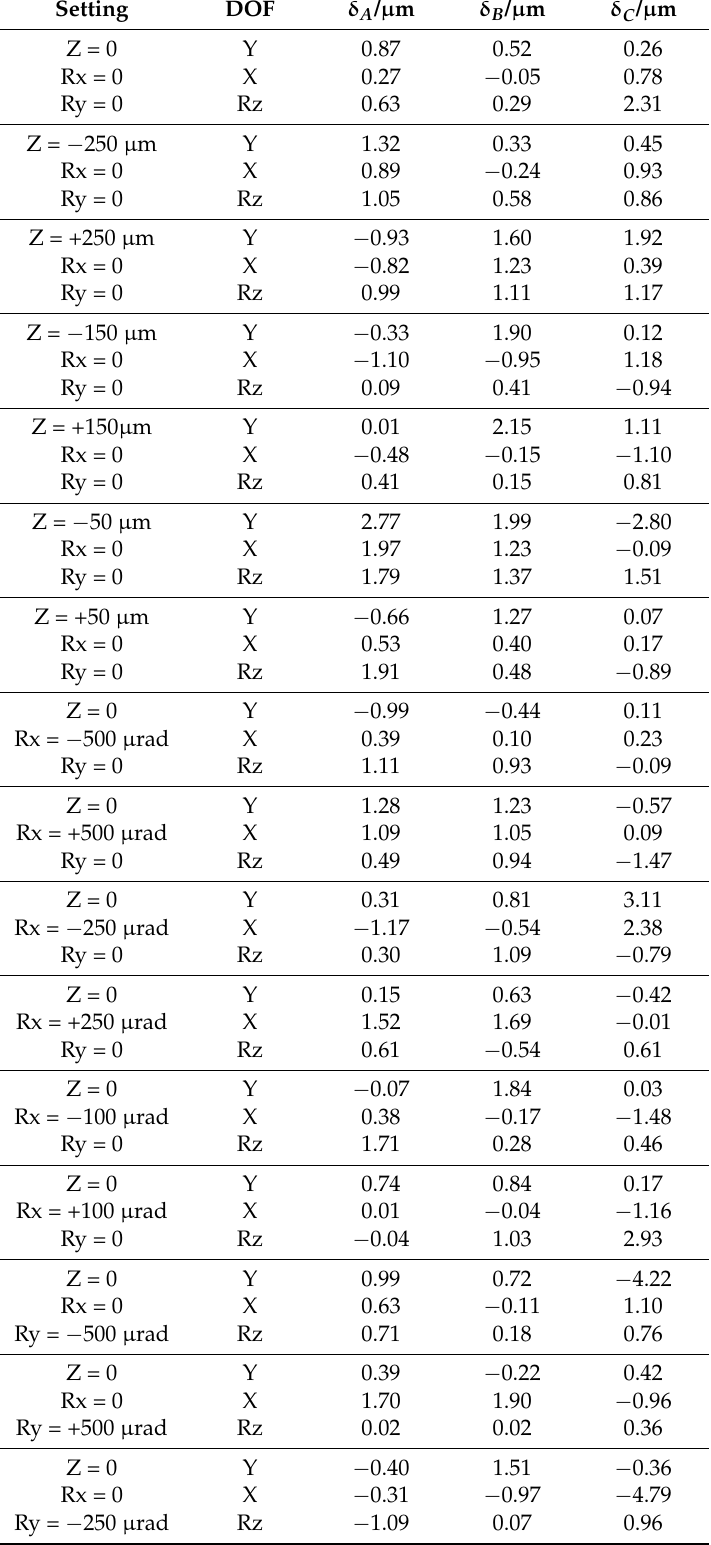
Table A1. The coefficients of zero deviation using model